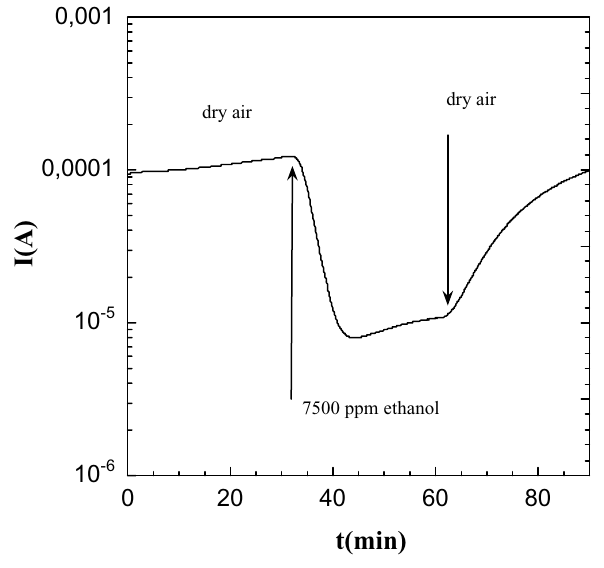
Figure 3. Dynamic electrical response of the device towards 7500 ppm of ethanol in dry air.